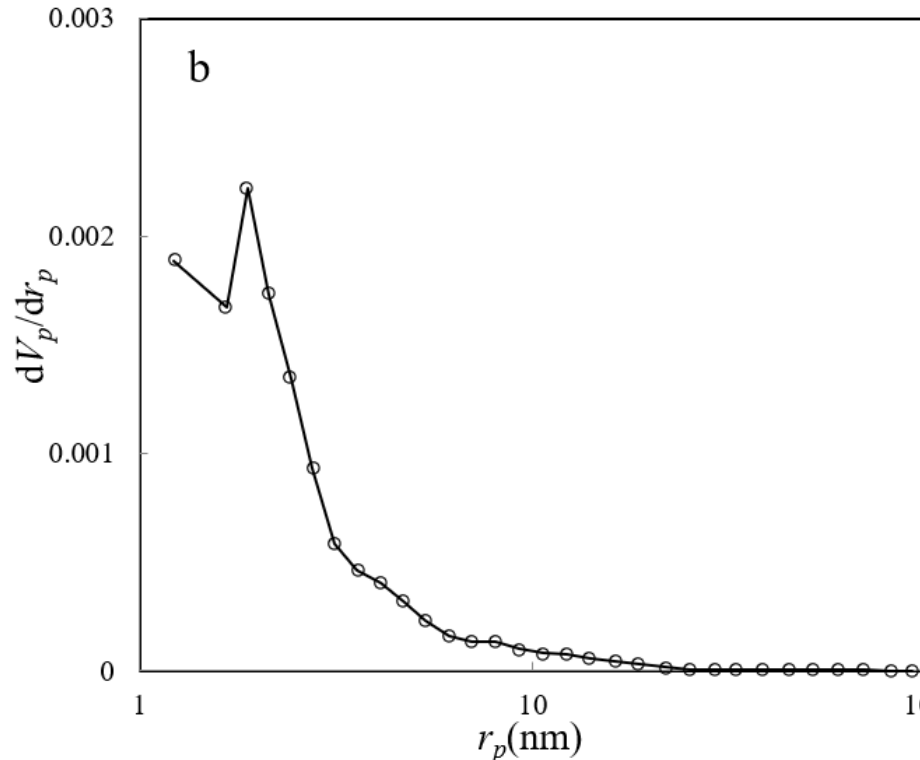
Figure 5. BET nitrogen adsorption–desorption ( a ) and BJH plot ( b ) of the ZHS nanoplates.